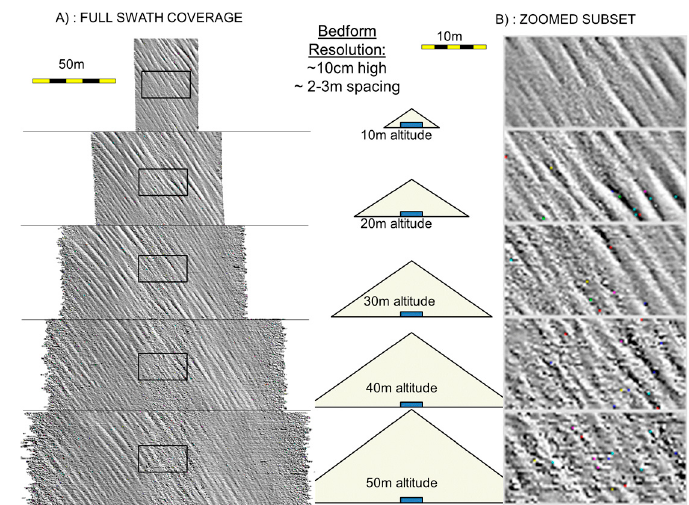
Figure 4. Illustrating the trade-off between AUV coverage and AUV resolution resulting from changing vehicle flying height. EM2040 0.7° × 0.7° system utilizing a ±60° sector. ( A ) Full swath coverage; ( B ) zoom of an identically sized (15 × 30 m) area showing the loss in feature definition and relative rise in bottom detection noise with vehicle elevation (the feature alignment is not identical due to limitations in the AUV navigation).